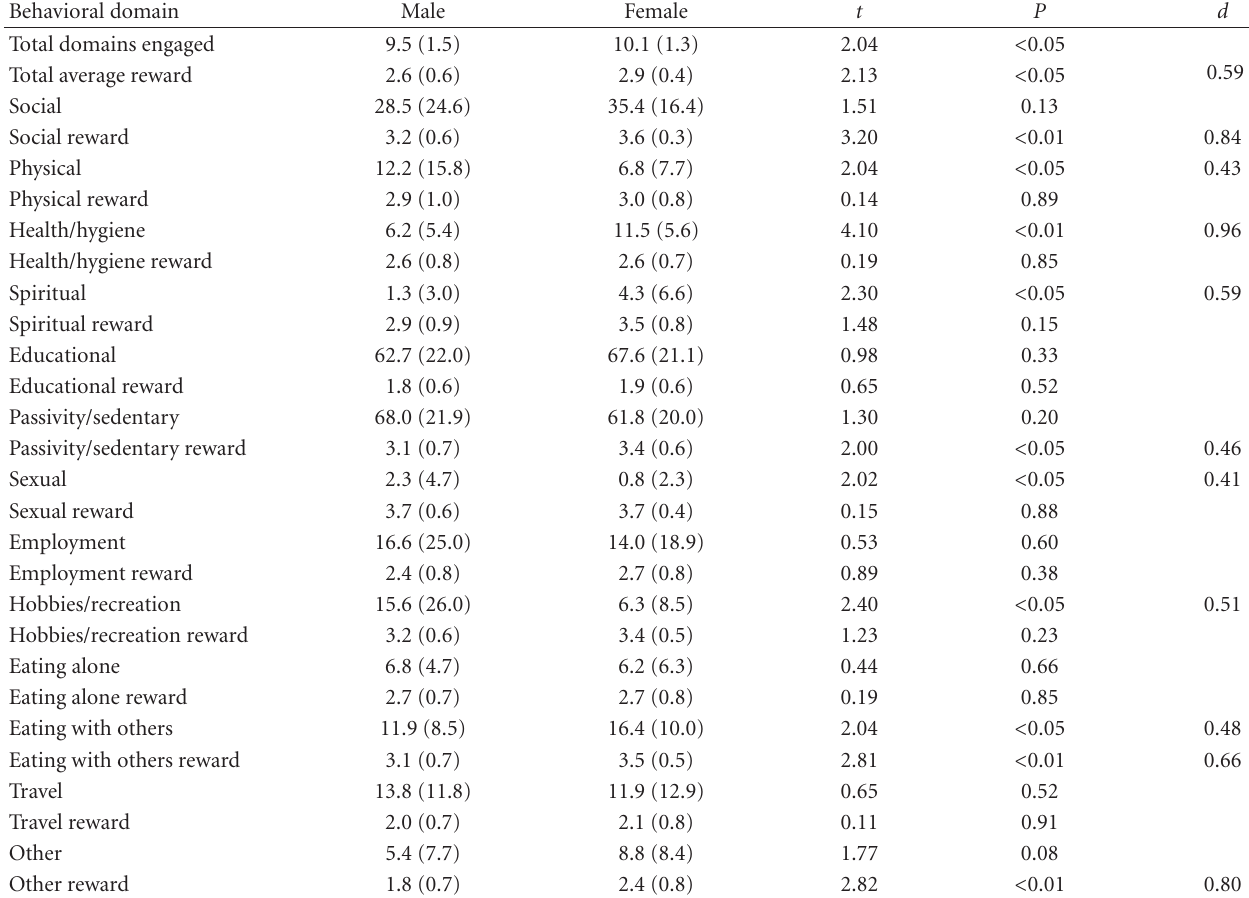
Table 1: Time duration and reward value of overt behaviors as a function of